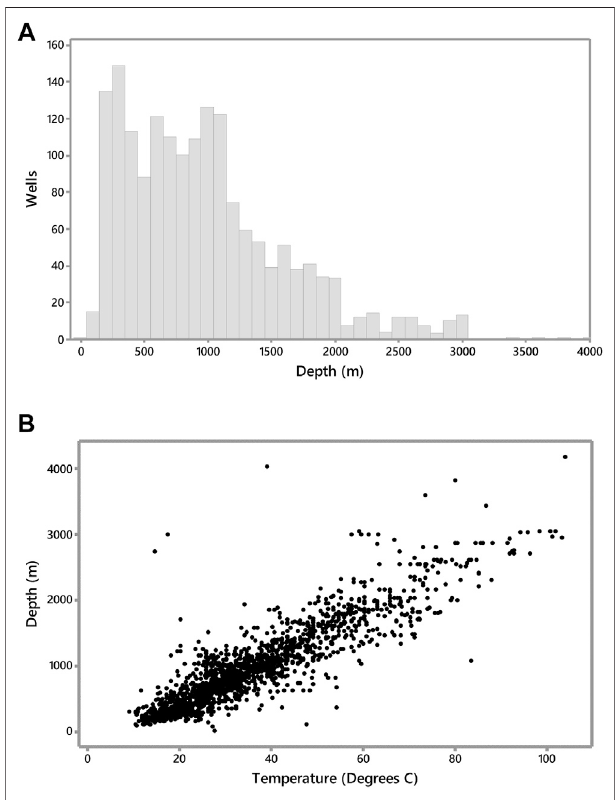
FIGURE 6 | Histogram of (A) temperature measurements by depth and (B) temperature vs depth plot.